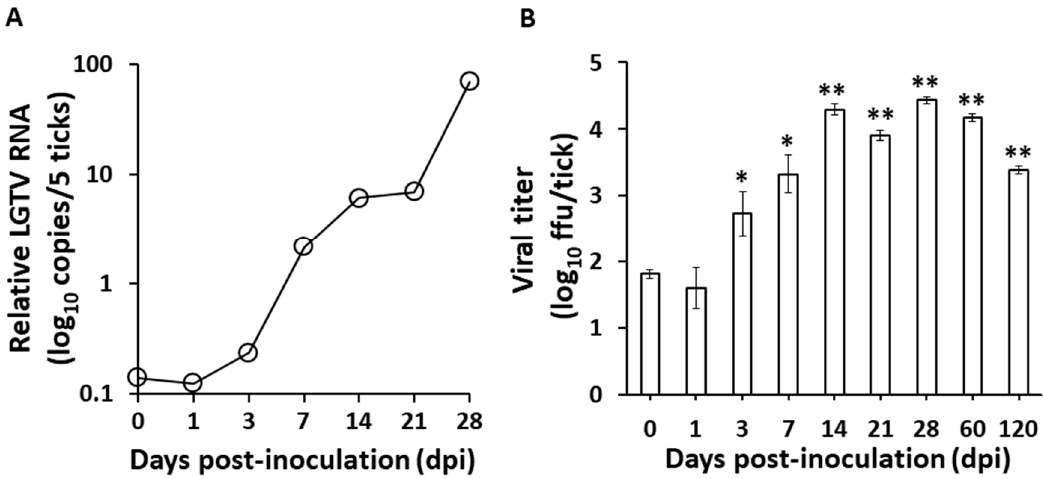
Figure 1. Replication of Langat virus in Haemaphysalis longicornis after infection via anal pore microinjection. ( A ) Real-time PCR was used to quantify the changes in the negative-sense strand of LGTV RNA collected from groups of five ticks at each time point. The H. longicornis L23 gene was used to normalize the data at each time point. ( B ) Virus titration after LGTV infection via anal pore microinjection. Error bars in virus titers indicate the SD in mean values of three ticks at each time point. * p < 0.05, ** p < 0.01, as compared to day